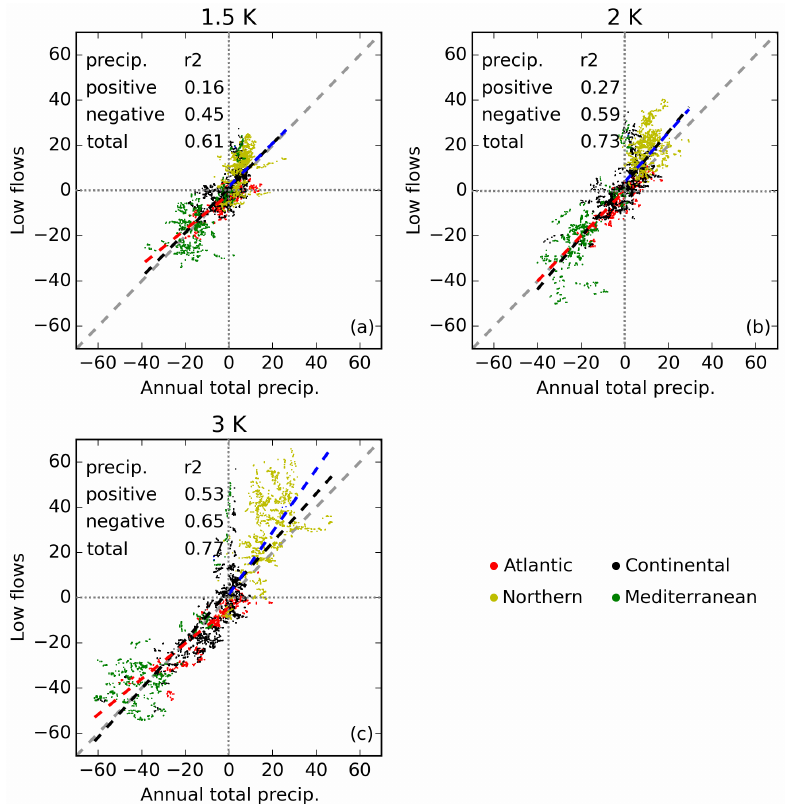
Figure 4. Relationship between the median changes in the annual total precipitation and simulated river low flows (Q90) under global warming of 1.5K (a) , 2K (b) , and 3K (c) . Unlike other results shown in this study, only river grid cells from basins greater than 10000km 2 are shown for clarity in the figure. Results are similar to those including river grid cells with contributing areas greater than 1000km 2 . Linear regression lines are shown for positive values (blue dashed), negative values (red dashed), and all data points (black dashed). The Alpine region with overall smaller catchment sizes is not included, but shows similar behaviour to the basins in the Northern region. All changes are expressed as multi-model ensemble mean changes (GCM/HM combinations for low flows and GCMs for annual